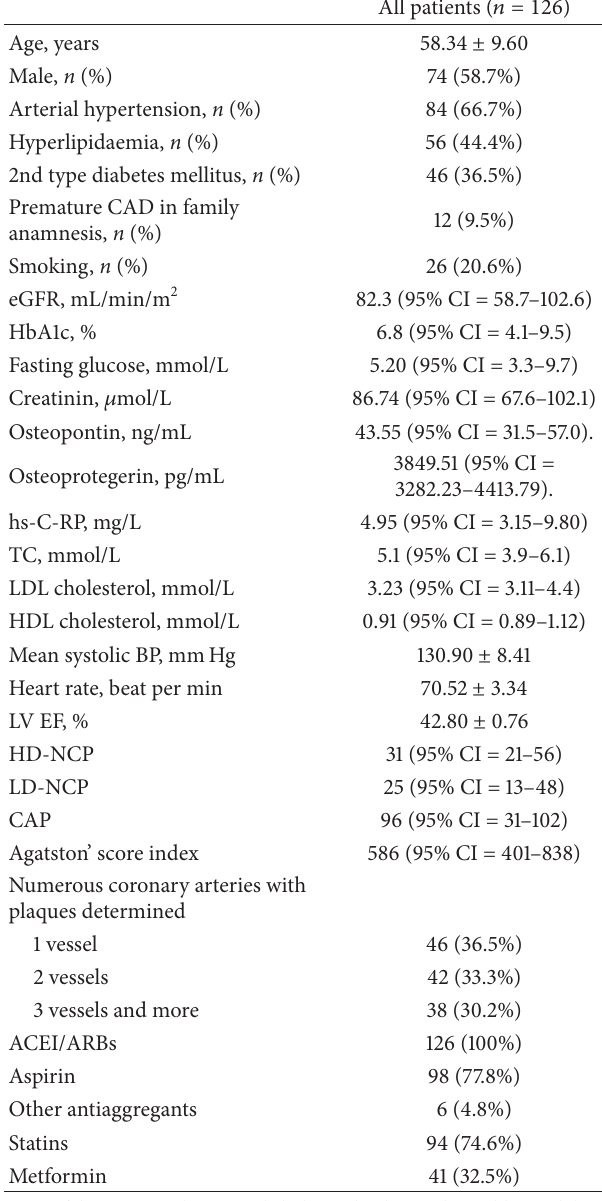
Table 1: General characteristics of study